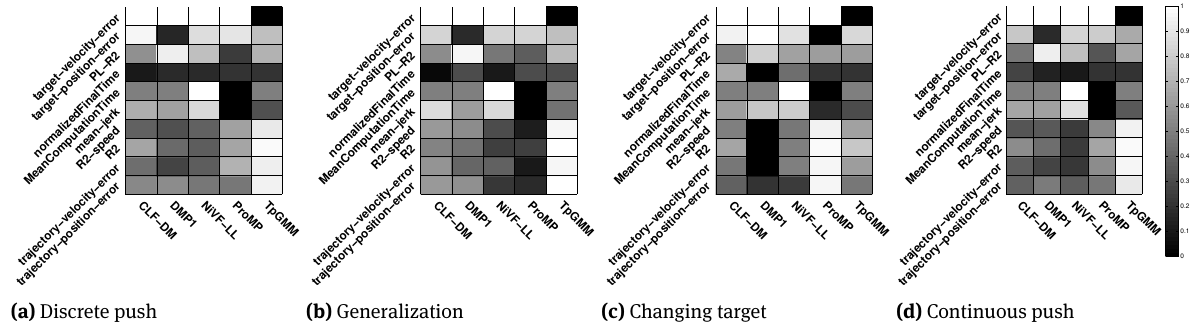
Figure 4: General overview of the results from four different benchmark scenarios. The task consist of reproduced learned trajectories aris- ing from perturbations specified in the four benchmark scenarios.Names of the different approaches are given on the x axes. Yaxes, identify different measure labels (see Table 1). Each square can have three different colors comparing all motion generation approaches to each other: high performance is shown as white, while low performance is represented by a black